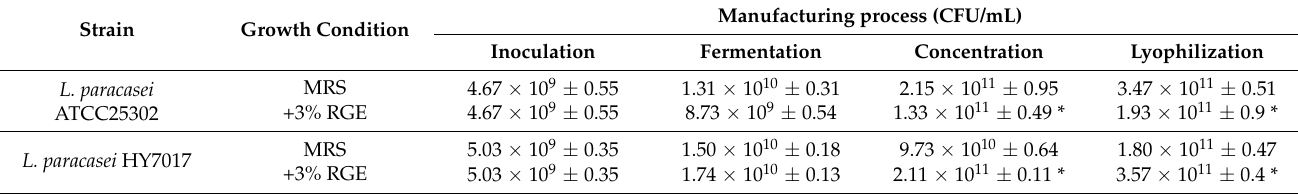
Table 2. Bacterial counts of Lactobacillus paracasei strains during the manufacturing process according to growth conditions. Manufacturing process (CFU/mL) Strain Growth Condition Inoculation Fermentation Concentration Lyophilization L. paracasei